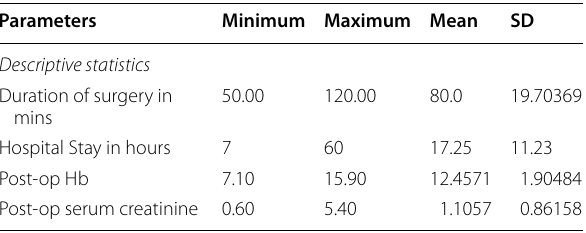
Table 3 Intraoperative parameters of patients undergoing mPCNL